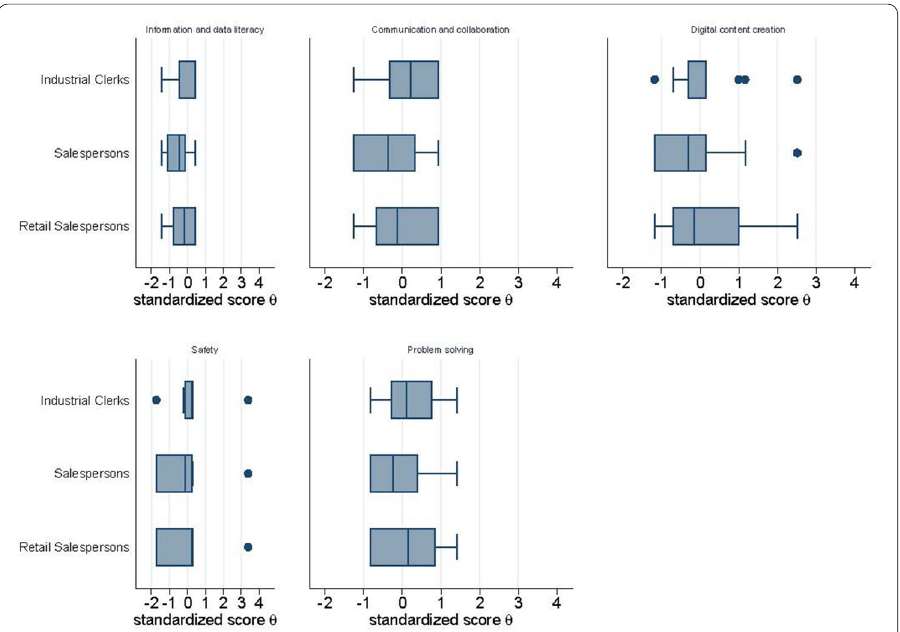
Fig. 2 Distribution of digital competences by profession (standardised score of